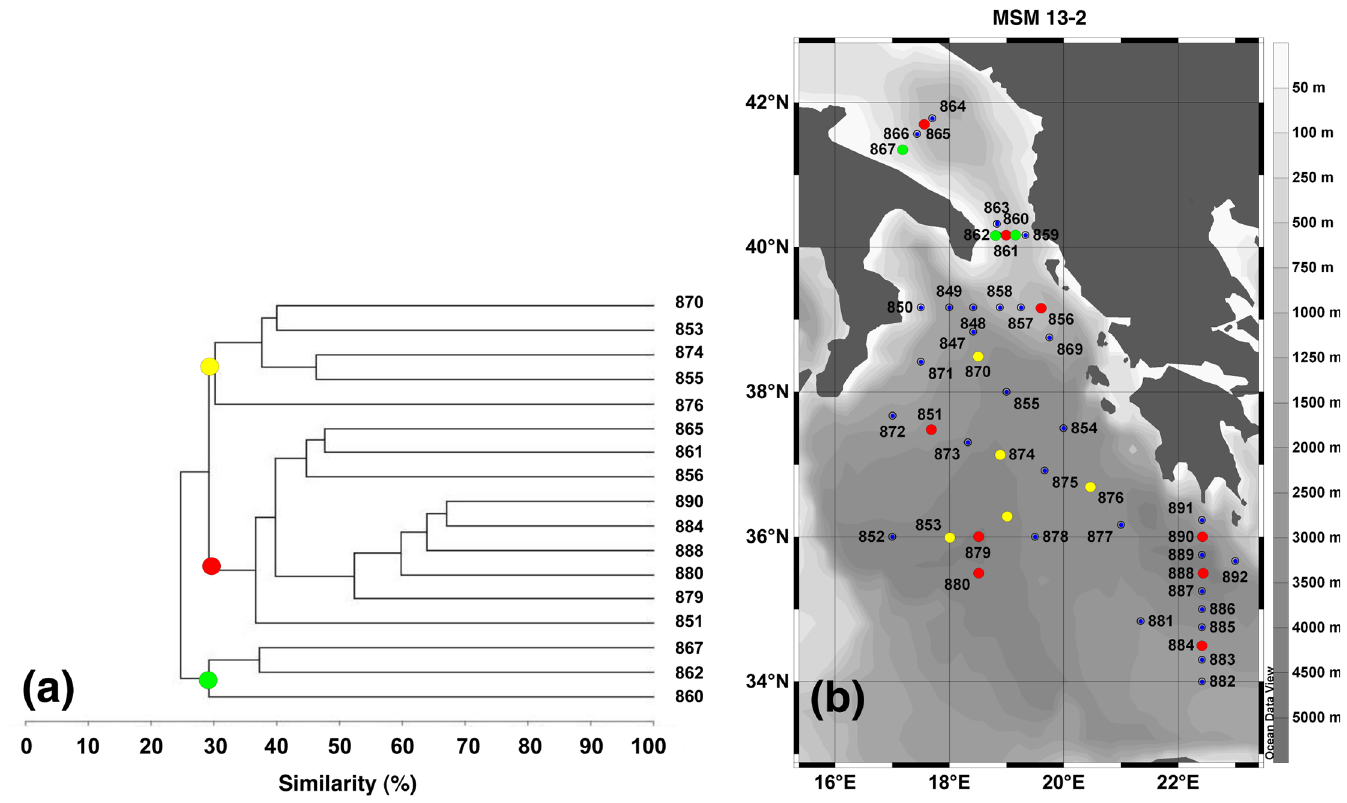
Fig 6. Grouping of the Eastern Mediterranean Sea bottom waters according to bacterial diversity. (a) Cluster analysis of the ARISA fingerprints. (b) Map of part of the Eastern Mediterranean Sea, where the stations for which ARISA was determined are delineated. Each color indicates stations belonging to the same